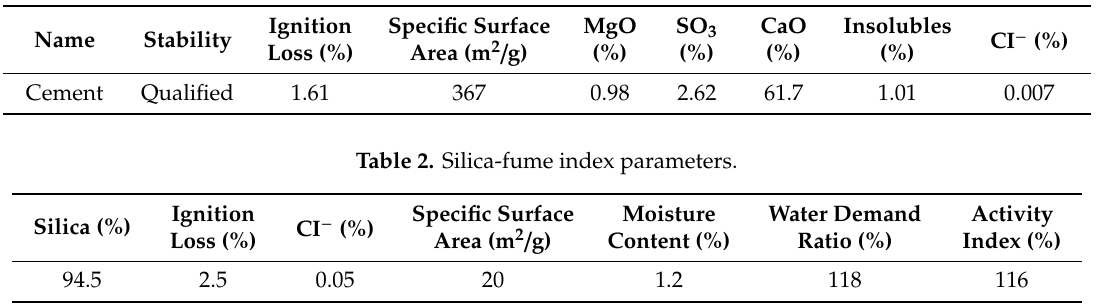
Table 1. Chemical composition and physical properties of cement.